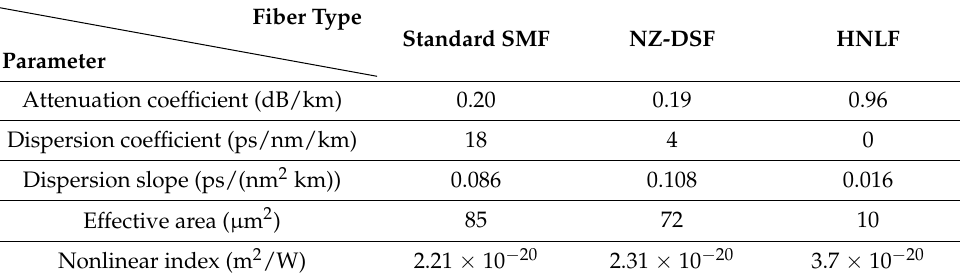
Table 1. Fiber parameters used for the transmission line.